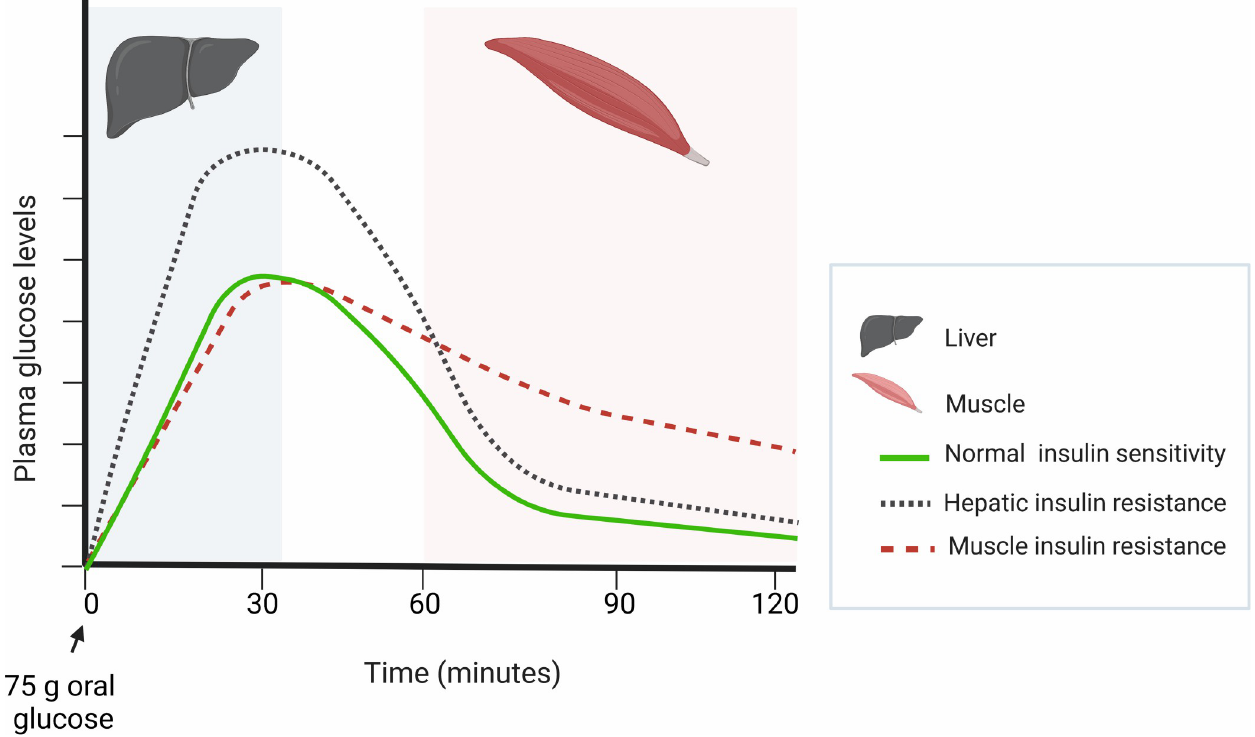
Fig 3. Anticipated patterns of changes in plasma glucose concentrations according to the primary site of insulin resistance. � � Based on information from Reference #33.